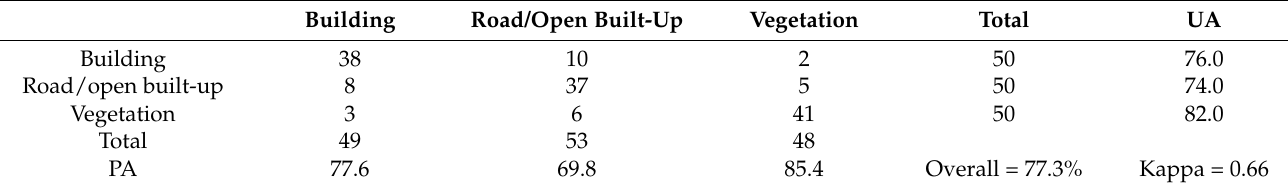
Table 4. Error matrix for VGG16 mapping (with Gaussian assistance) was generated using reference data derived from the visual interpretation of a WorldView-2 image and the Google Earth’s very high-resolution imagery archive. A total of 150 image objects were randomly selected for the accuracy assessment. UA and PA denote user’s and producer’s accuracy,